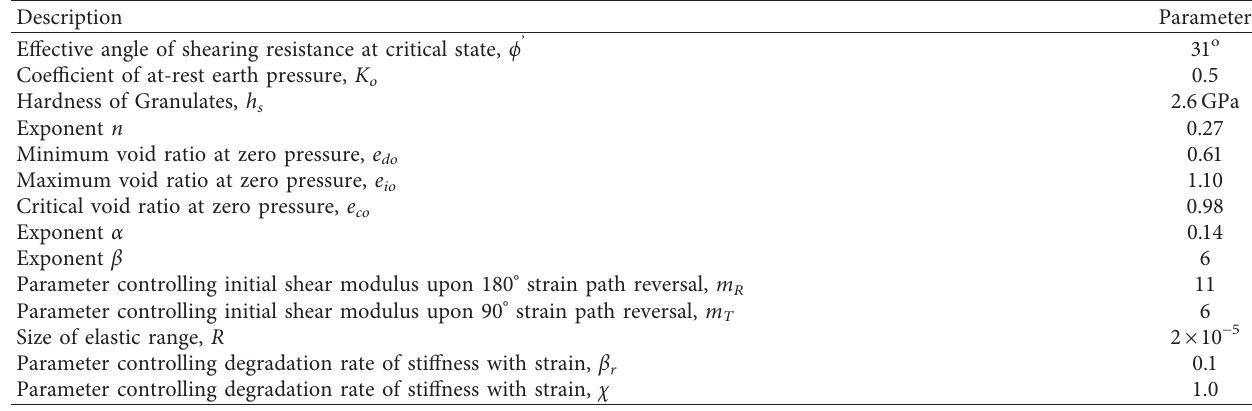
Table 2: Hypoplastic model parameters of sand adopted in this study.